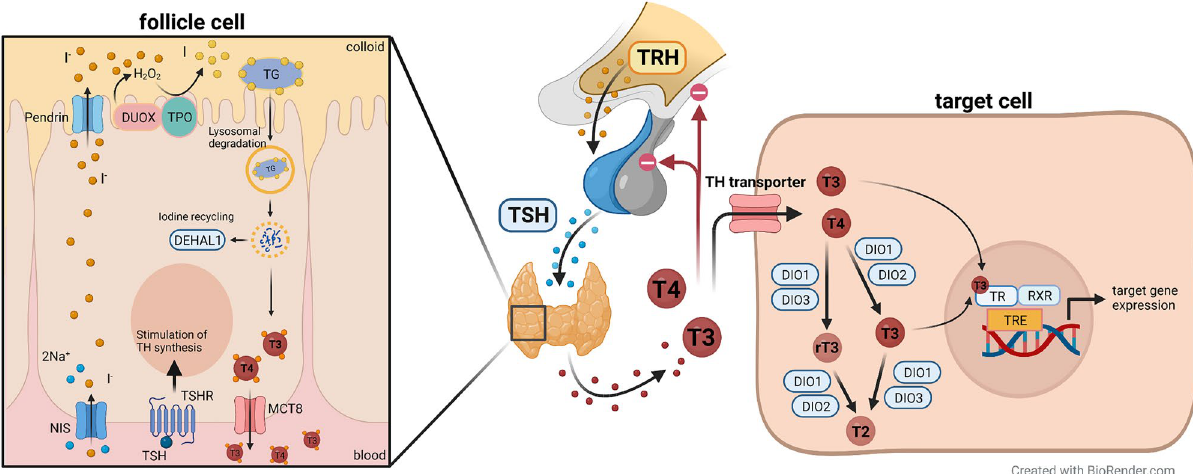
Figure 1. Synthesis and peripheral regulation of TH. To maintain a steady state regulation of TH availability, its synthesis, metabolism, and signalling are tightly regulated on several levels: TH synthesis by the thyroid gland is regulated by the HPT axis: TRH secreted by the hypothalamus stimulates the secretion of TSH from the pituitary. TSH then stimulates the thyroid gland to synthesise and secrete T4 and T3 by binding to TSHR. Secretion of TRH and TSH are negatively regulated by circulating THs. For TH synthesis, NIS takes up iodide into follicle cells, which is then transported into the follicle lumen by Pendrin. TPO catalyses the oxidation of iodide into iodine using H 2 O 2 , which is generated by DUOX. TPO also catalyses the organification of thyroglobulin, i.e. iodination of tyrosine residues forming MIT and DIT, as well as the final coupling of two DIT molecules or one MIT with one DIT to form T4 and T3, respectively. Thyroglobulin is internalised by thyrocytes via pinocytosis to degrade thyroglobulin and release T4 and T3 to the circulation. DEHAL1 is responsible for deiodination of MIT and DIT, playing a crucial role in iodide recycling. In the blood, the largest fraction of T4 and T3 is bound to plasma proteins. Only the free fractions (fT4, fT3) can enter target cells and exert their effects. At target tissues, cellular uptake and efflux of THs are facilitated by several transmembrane transporters. The best characterised TH transporters are MCT8 and OATP1C1. Within target cells, DIOs catalyse deiodination to either activate or inactivate THs. DIO1 and DIO2 are activating enzymes converting T4 into T3 and DIO3 is an inactivating DIO converting T4 and T3 into inactive metabolites, namely rT3 and 3,3 ′ - T2, respectively. DIO1 is further capable of inactivating T4 by conversion into rT3 and rT3 into 3,3 ′ -T2, albeit rT3 is the preferred substrate of DIO1. Within target cells, T3 regulates target gene expression by binding to TR subtypes TRα and TRβ. TH transporters, DIO, and TRs are expressed in a tissue- and age-specific manner, and TH effects in target cells result from a complex interplay between transport, activation/deactivation, and receptor-binding. TH, thyroid hormone; HPT axis, hypothalamic-pituitary-thyroid axis; TRH, thyrotropin- releasing hormone; TSH, thyroid-stimulating hormone; TSHR, TSH receptor; NIS, sodium/iodide symporter; TPO, thyroid peroxidase; DUOX, dual oxidase; MIT, monoiodotyrosine; DIT, diiodotyrosine; DEHAL1, iodotyrosine dehalogenase 1; fT4, free T4; fT3, free T3; MCT8, monocarboxylate transporter 8; OATP1C1, organic anion transporter 1C1; DIO, iodothyronine deiodinase; rT3, reverse T3 (3,3 ′ ,5 ′ -triiodothyronine); TR, thyroid hormone receptor. Graphical overview was created with